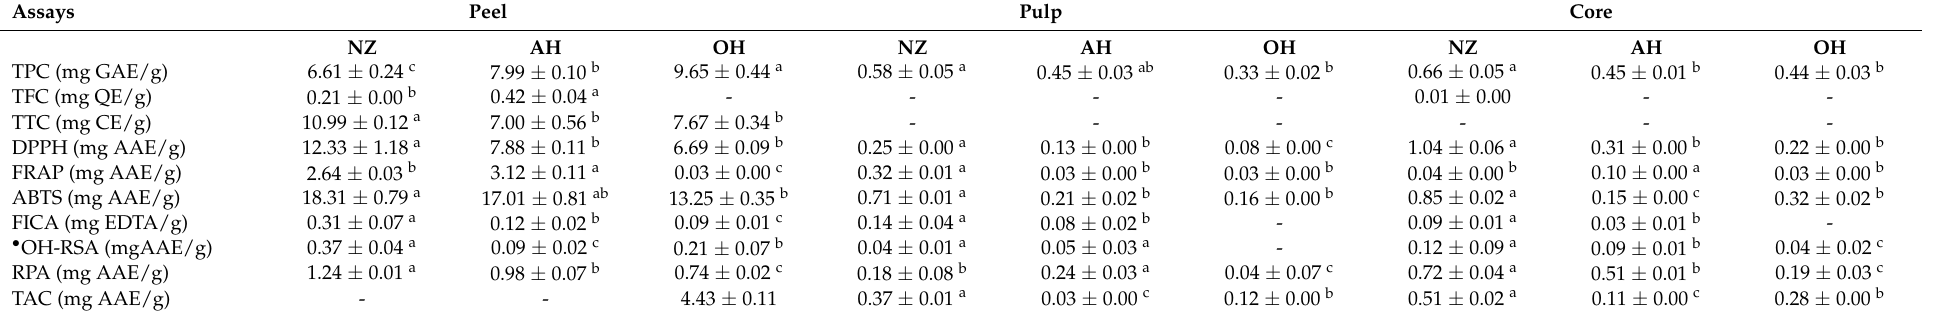
Table 1. Estimation of the phenolic content and antioxidant potential of different kiwifruit